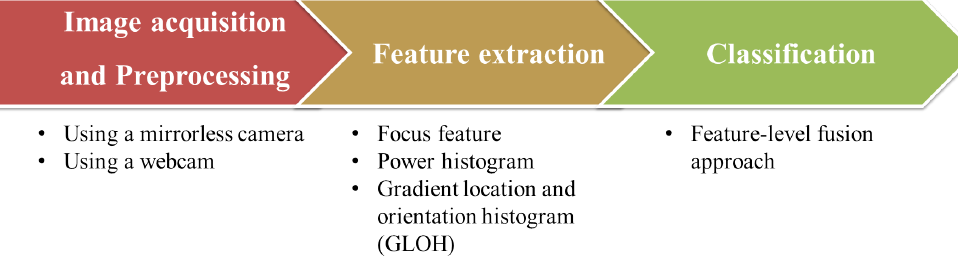
Figure 3. Flowchart of face liveness detection using